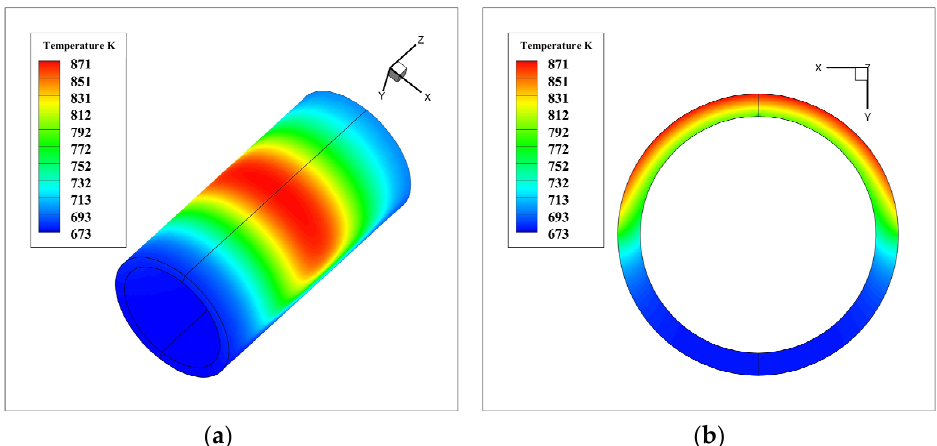
Figure 8. Temperature distribution of the tube. ( a ) Whole tube wall (z = 1:60); ( b ) Cross-wall of the tube (z = 0 m).